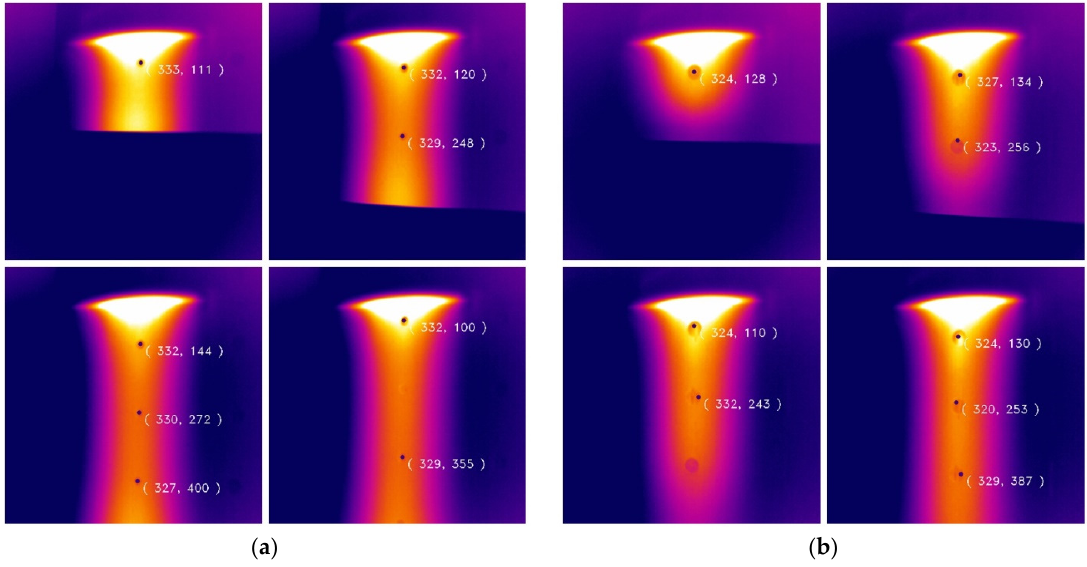
Figure 10. Impact defect detection results for defects of different diameters. ( a ) D3 mm defect detec ‐ tion and ( b ) D5 mm defect detection. detection and ( b ) D5 mm defect